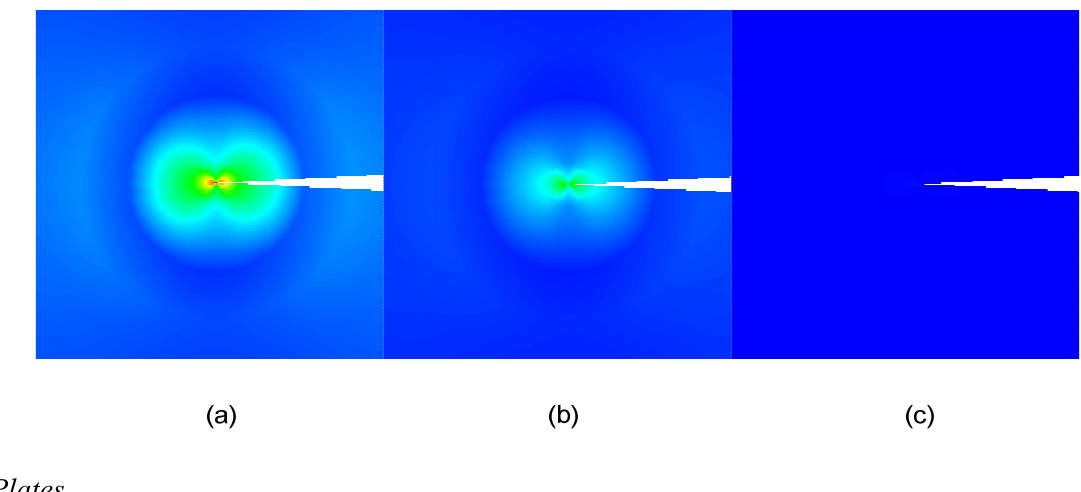
Figure 13. Von-Mises stress field around crack tip with different applied voltages on piezoelectric patches (a) 0 V, (b) 300 V and (c) 480 V (adopted from Figure 5 in